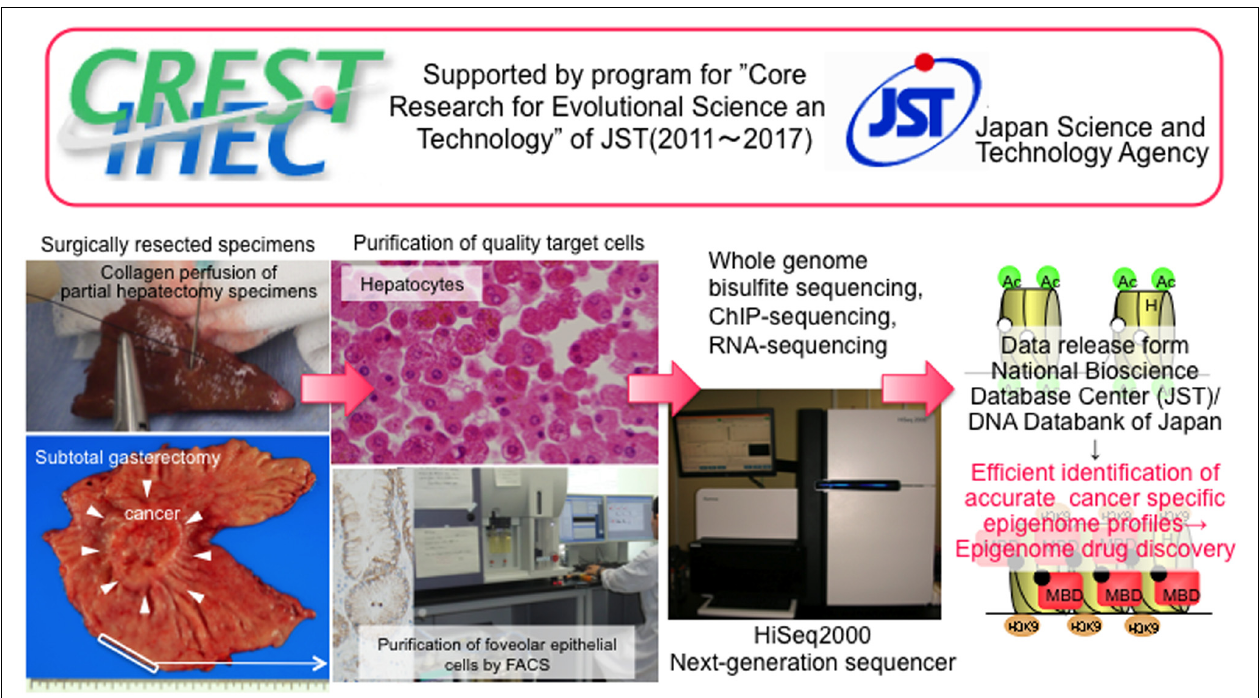
immunoprecipitation-sequencing, and RNA-sequencing of purified target cells, i.e., hepatocytes and other live cell lineages, foveolar epithelial cells, and other gastric epithelial cell lineages, and absorptive epithelial cells from the ascending and descending colon and rectum. Accurate epigenome profiling of normal cells will allow the identification of disease-specific epigenome profiles, thus facilitating a potential breakthrough in the prevention, diagnosis, and therapy of